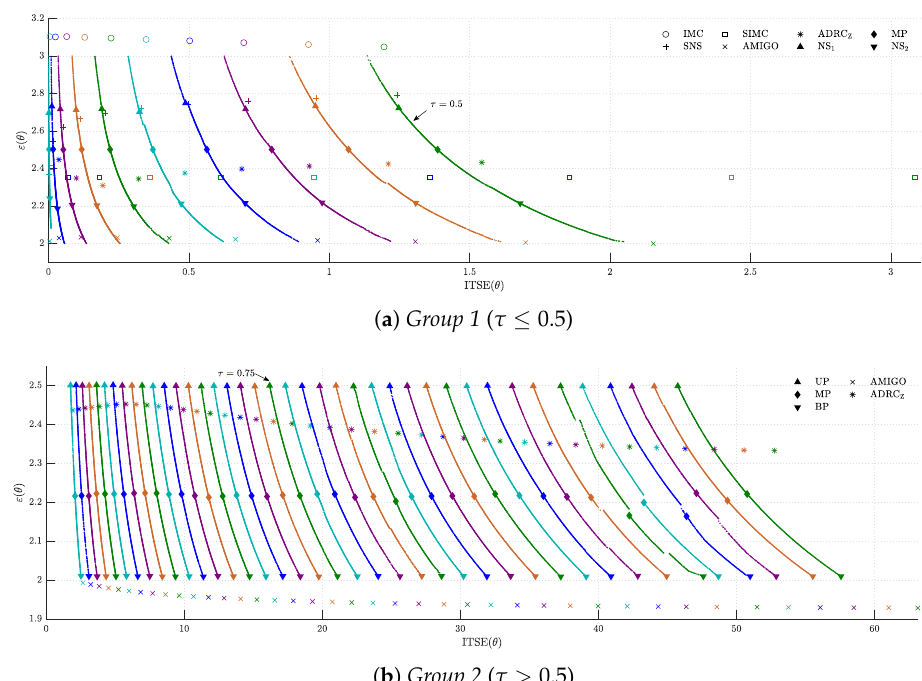
Figure 8. Pareto Fronts approximations and selected solutions for the complete set of nominal plants. Performance points obtained with the PID tuning methods IMC, SIMC, AMIGO, and SNS [34] as well as the LADRC tuning rules from [14] (ADRC Z ) are included for comparison. The SIMC points have been excluded from ( b ) for proper visualization because these alternatives are always dominated by the Pareto optimal solutions. Information related to the same plant has been plotted in the same